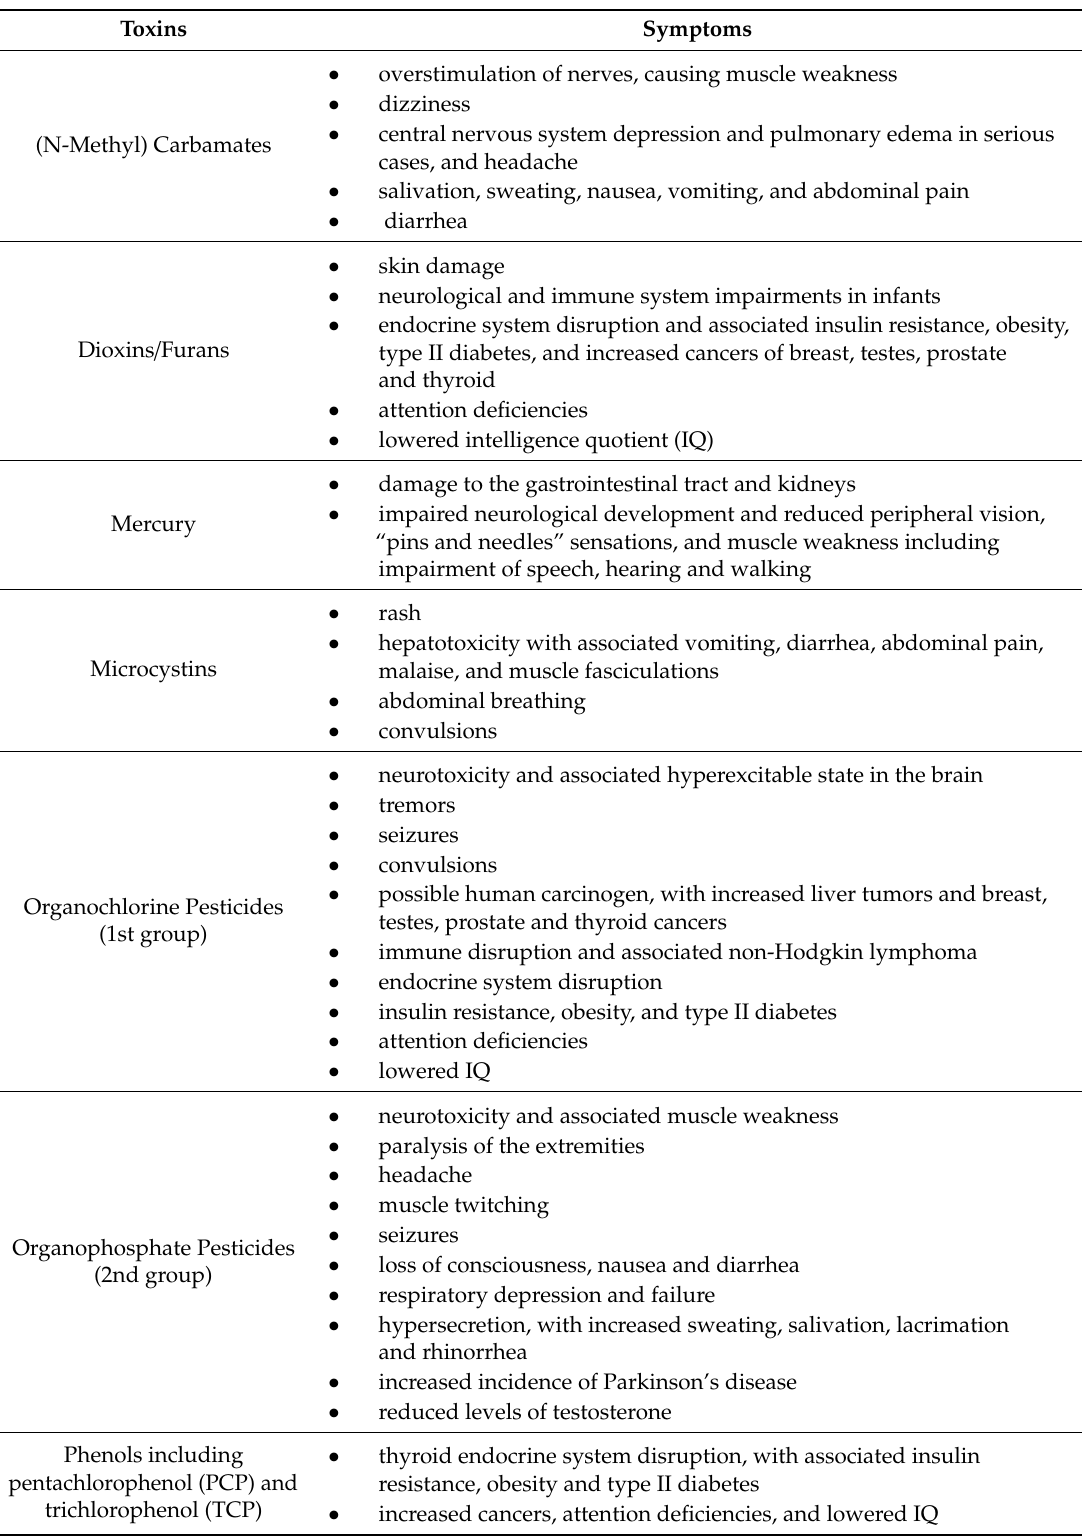
Table 1. Toxins present in Yurok culturally significant species and environment, and